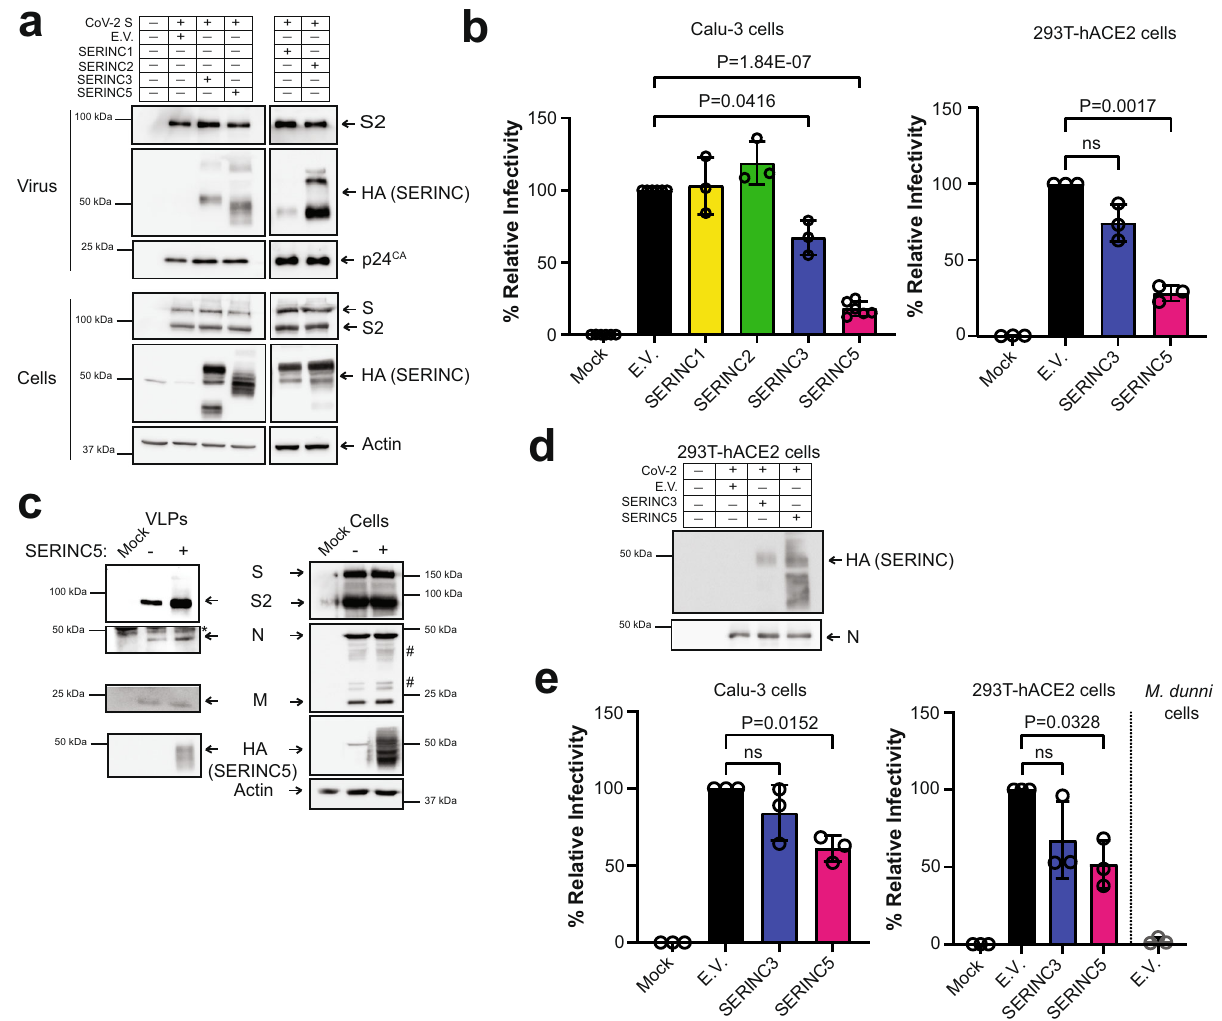
Fig. 2 SERINC proteins are incorporated into SARS-CoV-2 virus and restrict SARS-CoV-2 S-mediated entry. a SERINC proteins are incorporated in SARS-CoV-2 S pseudoviruses. 293T cells were co-transfected with HIV-1 NL Δ Env-NanoLuc, SARS-CoV-2 Spike and either SERINC1, 2, 3, 5, or empty vector (E.V.) as indicated. Subsequently, cells and released pseudovirus in the culture media were harvested and the indicated proteins were analyzed by immunoblotting. b SERINC5 blocks SARS-CoV-2 S – mediated entry. Calu-3 or 293T-hACE2 cells were infected with SARS-CoV-2 S pseudoviruses produced in the presence of SERINC1, 2, 3, 5, or E.V. Luciferase levels were measured 48 hpi and normalized to HIV-1 p24 CA levels of the input virus. The percentage (%) of relative infectivity with respect to pseudovirus produced in the presence of empty vector is shown. c SERINC5 is incorporated in virus- like particles (VLPs). VLPs were generated either with SERINC5 or E.V and subsequently analyzed by immunoblotting. * denotes nonspeci fi c band, # represents glycosylated forms of M protein. d SERINC5 is incorporated in infectious SARS-CoV-2 virions. SARS-CoV-2 particles were produced in 293T- hACE2 cells expressing either SERINC3, SERINC5 or E.V. Virions released in the culture media were harvested and the indicated proteins were analyzed by immunoblotting. e SERINC5 inhibits SARS-CoV-2 infectivity. Calu-3, 293T-hACE2 or Mus dunni ( M. dunni ) cells were infected with SARS-CoV-2 virions (normalized for viral RNA copies) produced in the presence of SERINC3, 5 or E.V (from Fig. 2d). Six hours post infection, SARS-CoV-2 Spike RNA copy number in the infected cells were determined by RT-qPCR, normalized to GAPDH, and presented as % relative to E.V., which was set to 100%. For a , c , and d , representative immunoblotting results from n = 3 independent experiments are shown. Uncropped blots are in Source Data. For b and e , results are presented as mean ± SD from at n = 3 or 6 independent experiments. Statistical signi fi cance was determined by one-sample t-test (two-tailed). (empty vector, E.V.; SARS-CoV-2 Spike, S; SARS-CoV-2 Spike S2 subunit, S2; M, membrane protein; N, nucleocapsid protein; Mus dunni cells, M. dunni cells; not signi fi cant,